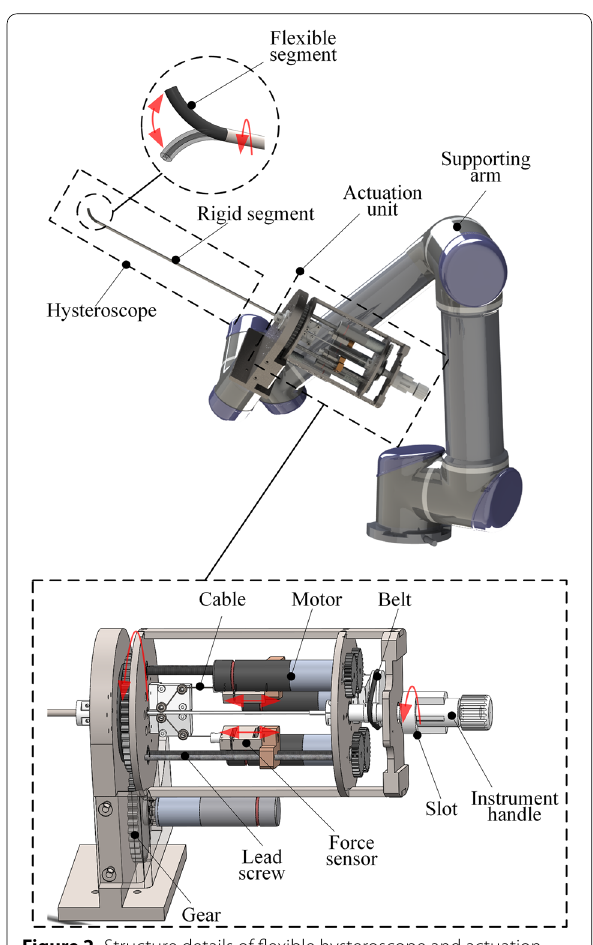
Figure 2 Structure details of flexible hysteroscope and actuation